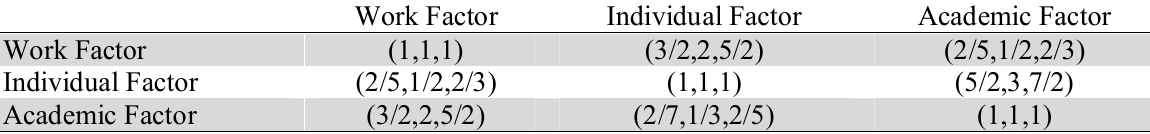
Value of First Hierarchy